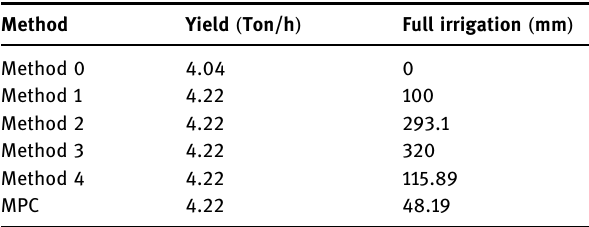
Table 2: Field yield and total irrigation for the Year 2017 Method Yield ( Ton/h ) Full irrigation ( mm